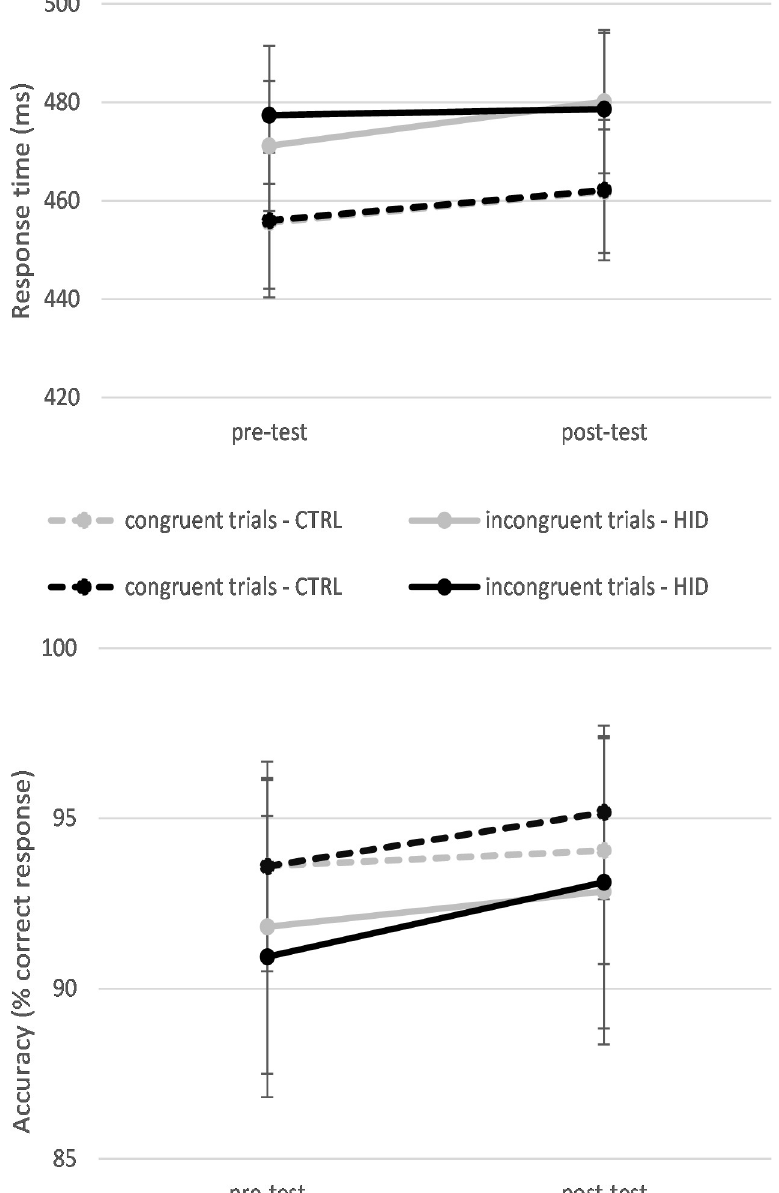
Fig 4. Descriptive statistics (exact mean and standard error of the mean) representing the evolution of response time (upper panel) and accuracy (lower panel) as a function of the time of measurement (pre-test vs . post-test) and as a function of the level of inhibition in the Stroop task (control condition, CTRL vs . high inhibition demands, HID) in Study 2. Note that the data of response time for the congruent trials in the control condition is not visible on the graph as it is located exactly under the data of response time for the congruent trials in the high inhibition demands